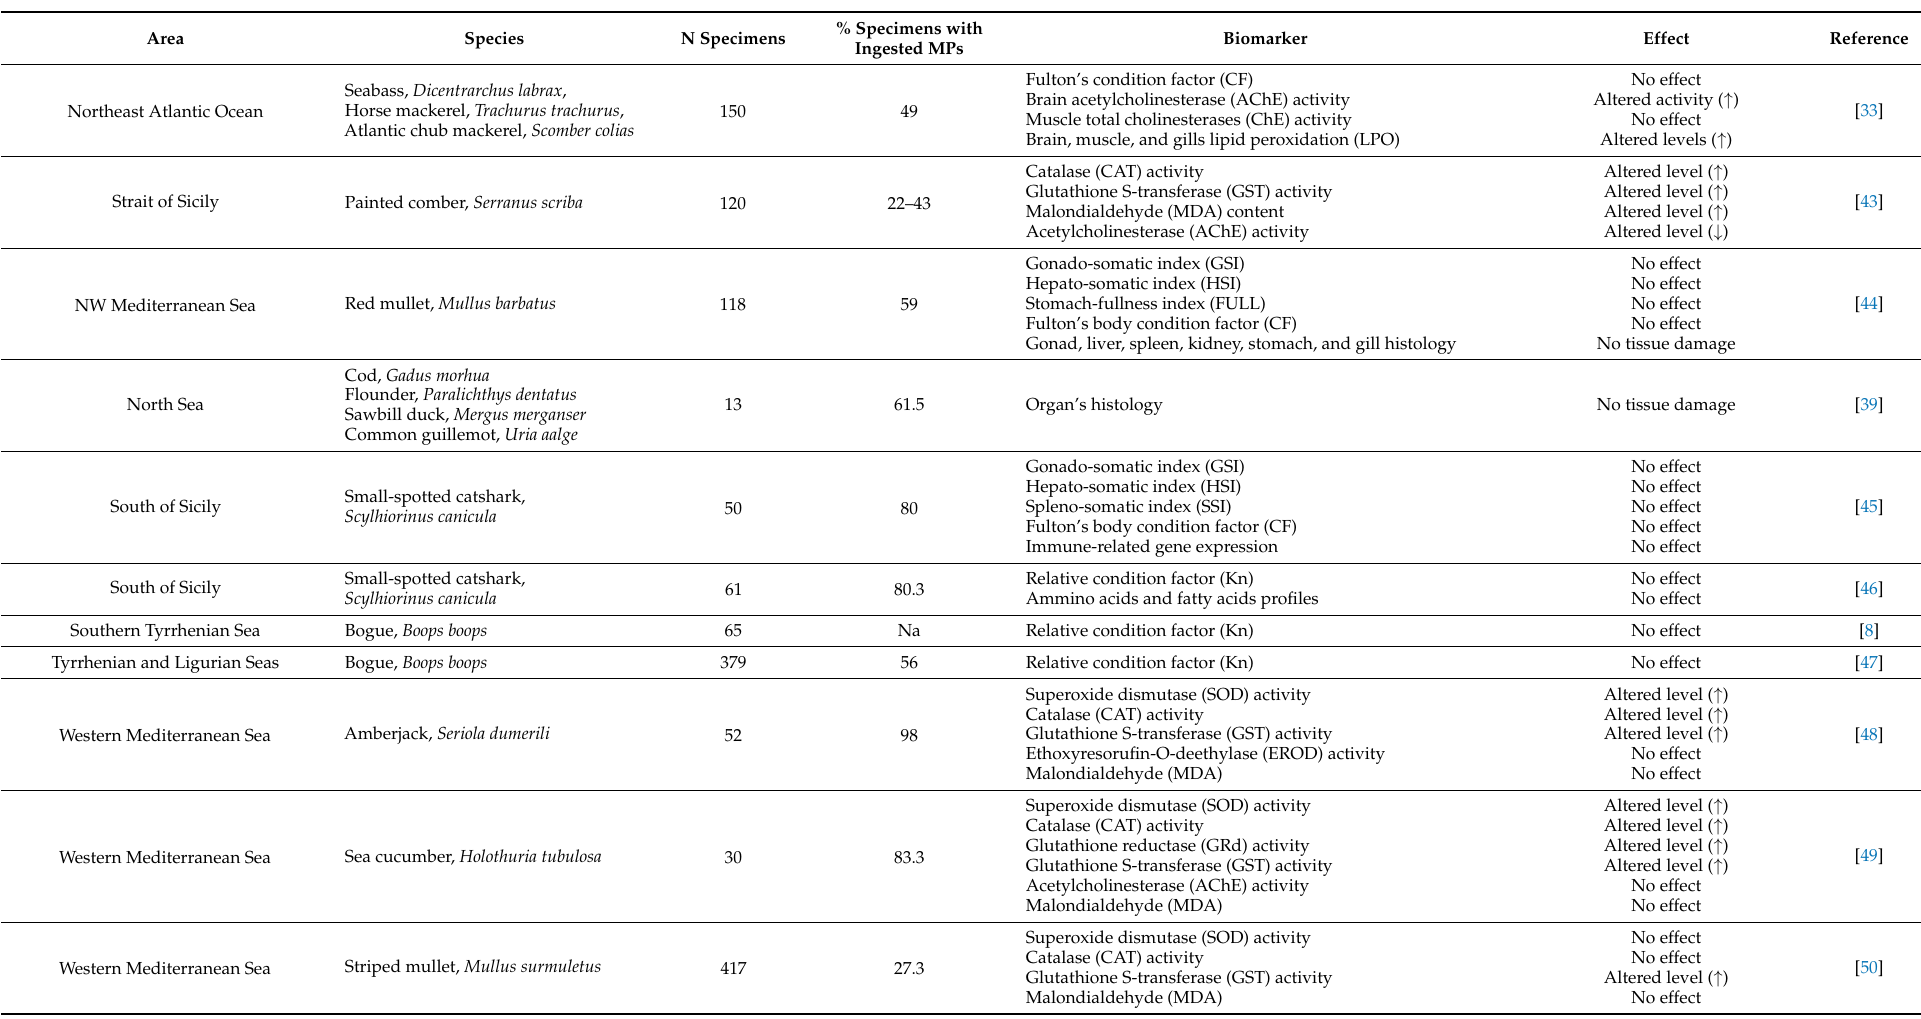
Table 1. Summary of effects caused by microplastic ingestion in wild marine